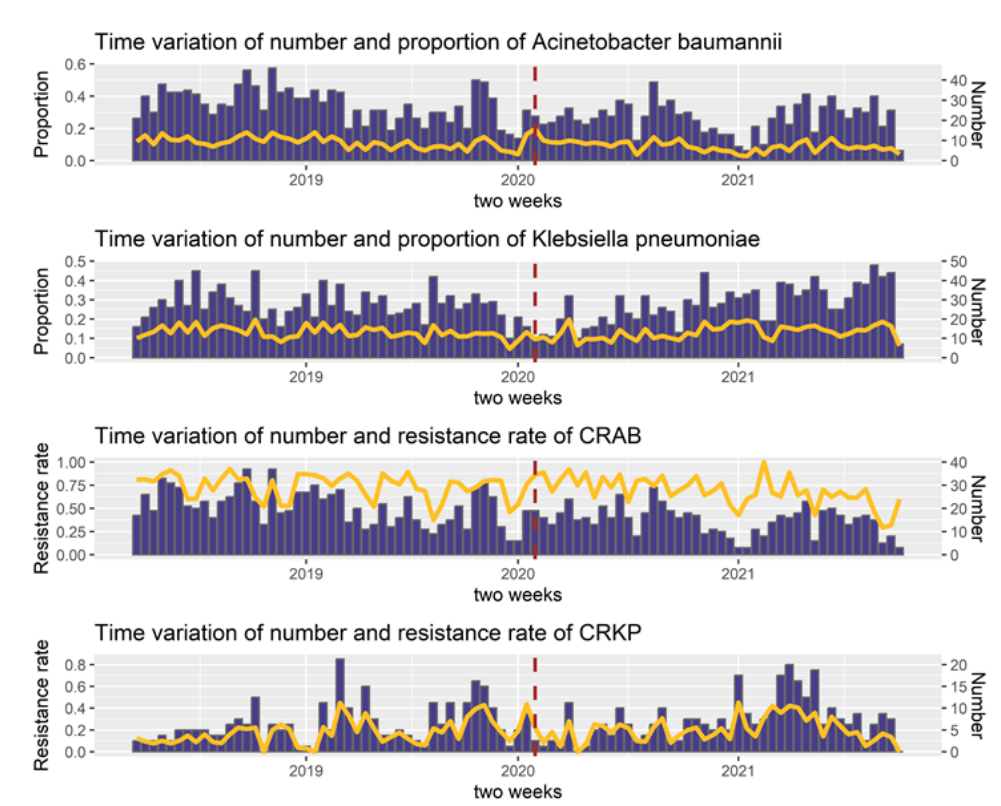
Figure 1. Time trends of pathogens and drug-resistant bacteria. Data were collected on a biweekly basis. The dark red dashed line indicates the COVID-19 outbreak. The yellow line represents the proportion of the pathogen or resistance rate of the drug-resistant bacteria. The blue bars show the number of pathogenic or drug-resistant